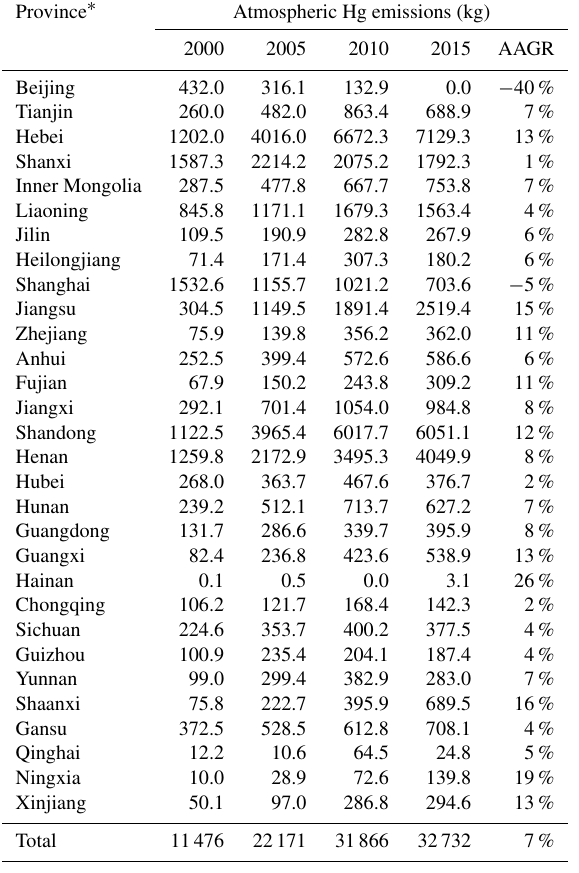
∗ Provinces without data are not listed in this table.